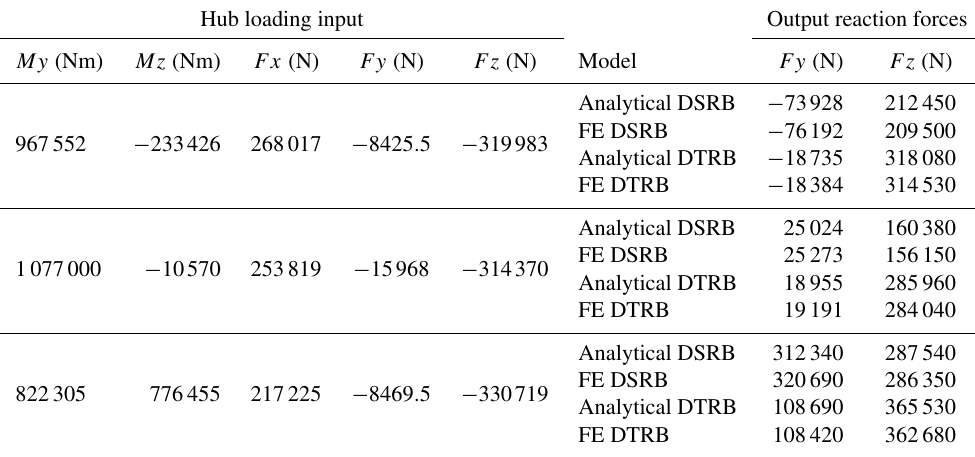
Table A1 contains example input and output values for all models used in this work. Table A1. Hub loading inputs and corresponding model outputs at various time steps. Quantities are in the DNV GL Bladed reference